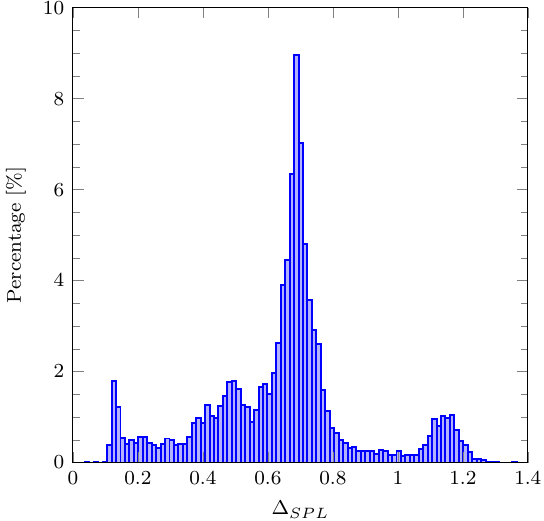
Figure 11. Histogram of the ∆ SPL values from the DEMAND dataset. ∆ SPL denotes the abso- lute error between the SPL values obtained with the proposed approximate and the reference A-weighting